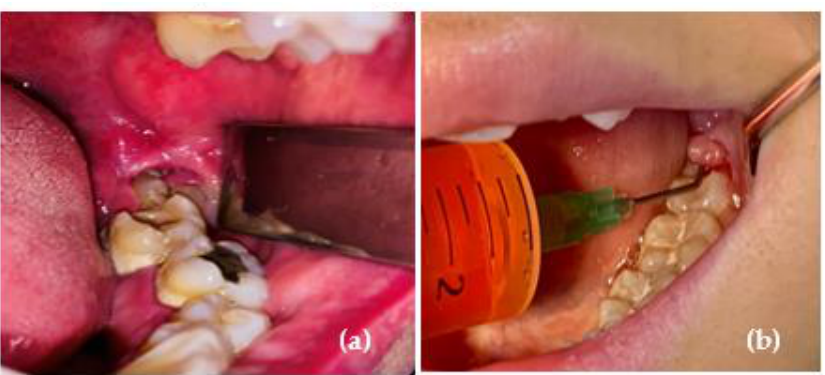
Figure 1. Aspect of the lower third molar eruption ( a ) and local irrigation in pericoronitis ( b ).